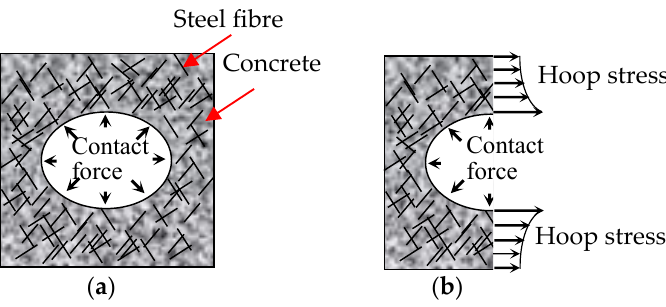
Figure 21. Diagram of ( a ) force in the interface between yarns and matrix and ( b ) stress of the cementitious matrix after releasing the pre-tension on textile.